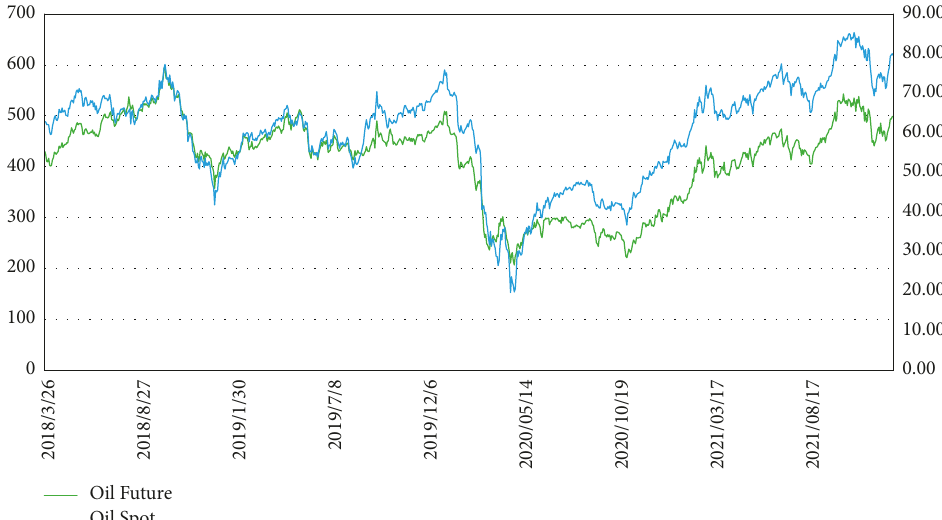
Figure 3: Crude oil futures (RMB per barrel) and spot (USD per barrel) from March 26, 2018, to December 31, 2021.